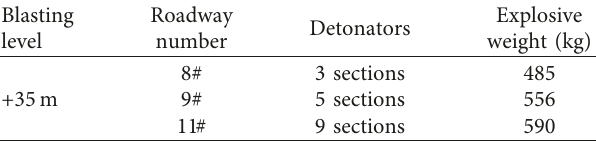
Table 4: Blasting parameters at +35m on May 13.